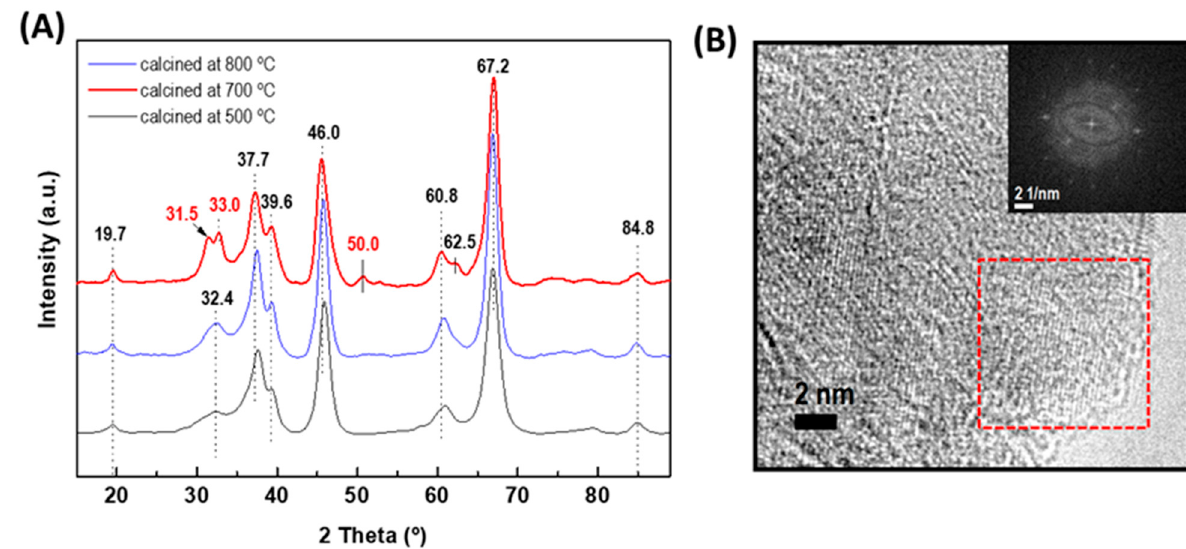
Figure 2 . ( A ) XRD patterns of the γ‐ alumina support calcined at different temperatures (500, 700, and 800 °C). ( B ) HRTEM image of the γ‐ alumina calcined at 800 °C. The inset shows the fast Fourier transform (FFT) image corresponding to the area marked with a red square in the HRTEM image.